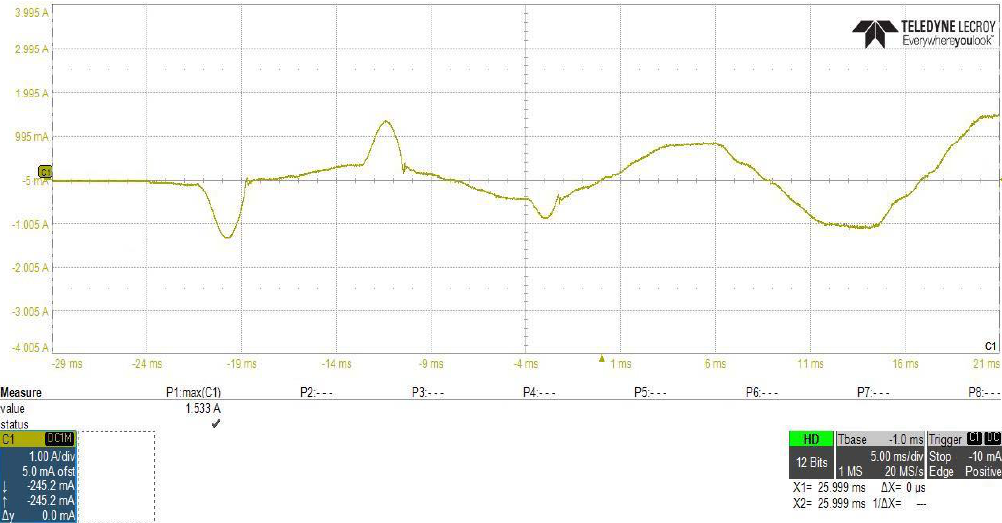
proposed inrush current mitigation circuit.